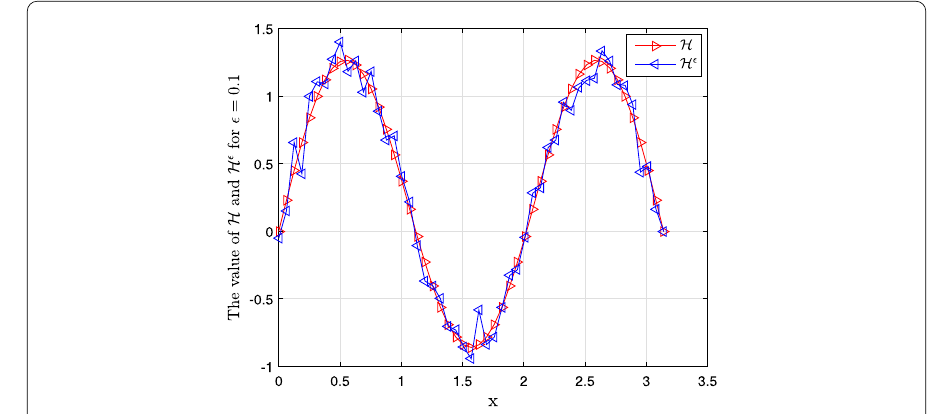
Figure 1 The function H and H ε for x ∈ [0, π ], α = β = 0.5, and ε =